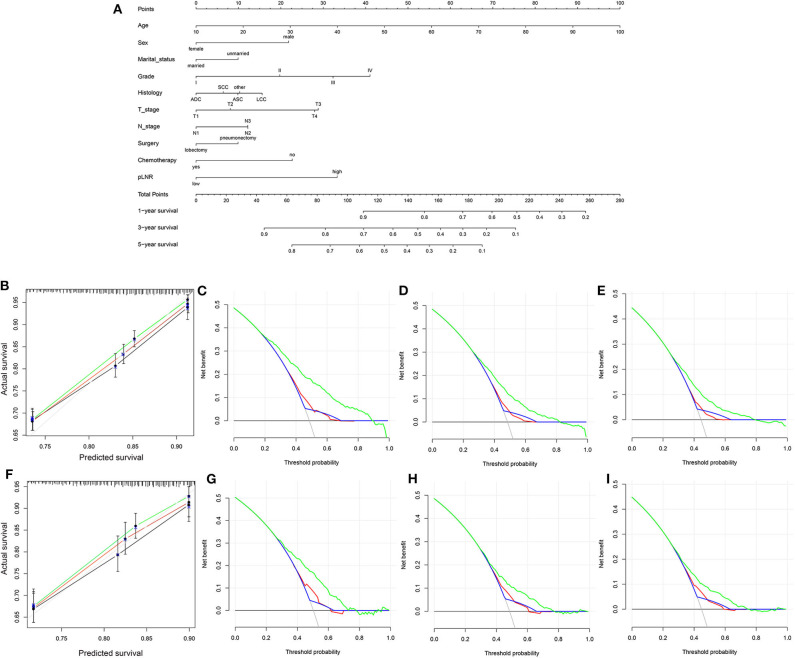
(A) Nomogram used to predict the 1-, 3-, and 5-year CSS rates of patients with T1−4N1−3M0 NSCLC. (B) Calibration curve of the nomogram for predicting the 1-, 3-, and 5-year CSS rates of patients with T1−4N1−3M0 NSCLC from the training set. Decision curve analysis of the AJCC 7th stage, nomogram and positive lymph node ratio (pLNR) for the 1- (C), 3- (D) and 5-year (E) CSS rates of patients with T1−4N1−3M0 NSCLC from the training set. (F) Calibration curve of the nomogram for predicting the 1-, 3-, and 5-year CSS rates of patients with T1−4N1−3M0 NSCLC from the validation set. Decision curve analysis of the AJCC 7th stage, nomogram and pLNR for the 1- (G), 3- (H), and 5-year (I) CSS rates of patients with T1−4N1−3M0 NSCLC from the validation set. CSS, cancer-specific survival; pLNR, positive lymph node ratio; NSCLC, non-small cell lung cancer. For calibration curves, green, red, and black line represent 1, 3, and 5 years, respectively. For decision curve analysis, green represents the nomogram, red represents pLNR, and blue represents AJCC 7th stage.